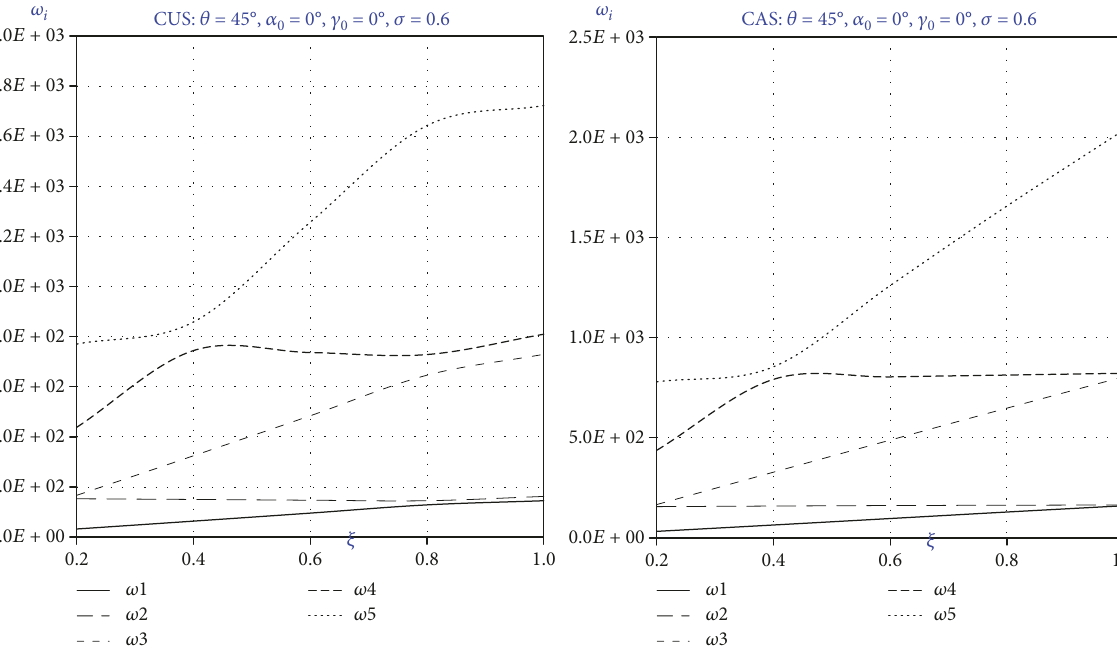
Figure 15: Eigenfrequencies vs. ply angle of Model A via ξ for CUS and